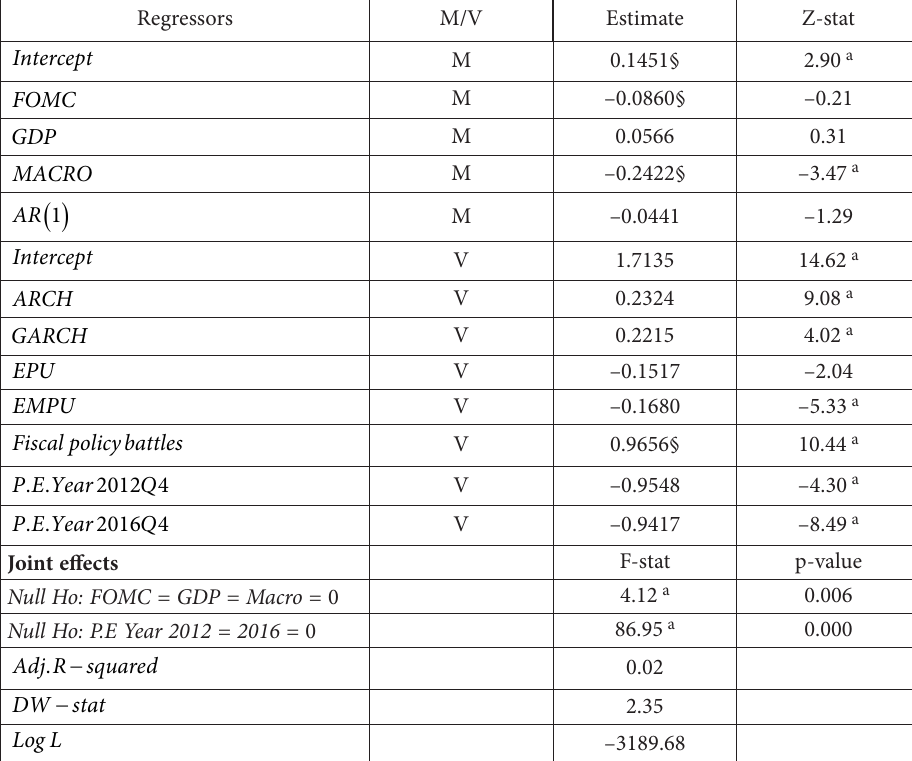
Table 13. Economic policy uncertainty and soybean implied volatility index